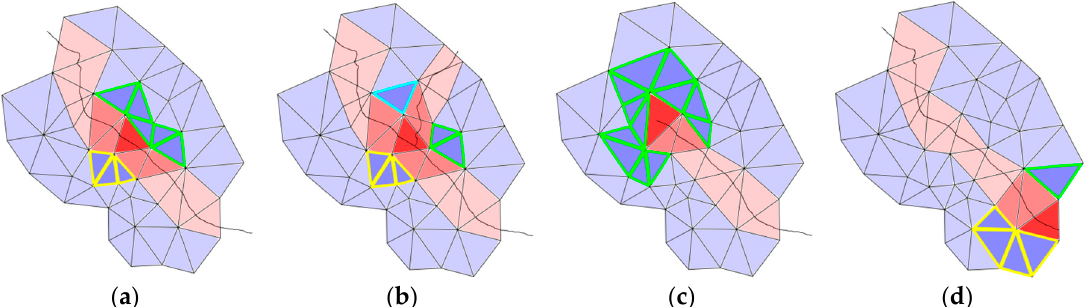
Figure 6. Neighborhood analysis: The bold red triangle is the crack candidate that is considered; darker blue triangles are non-deformed neighbor triangles: ( a ) Standard case with two components; ( b ) crack junction; ( c ) crack tip; ( d ) crack candidate at the mesh boundary.